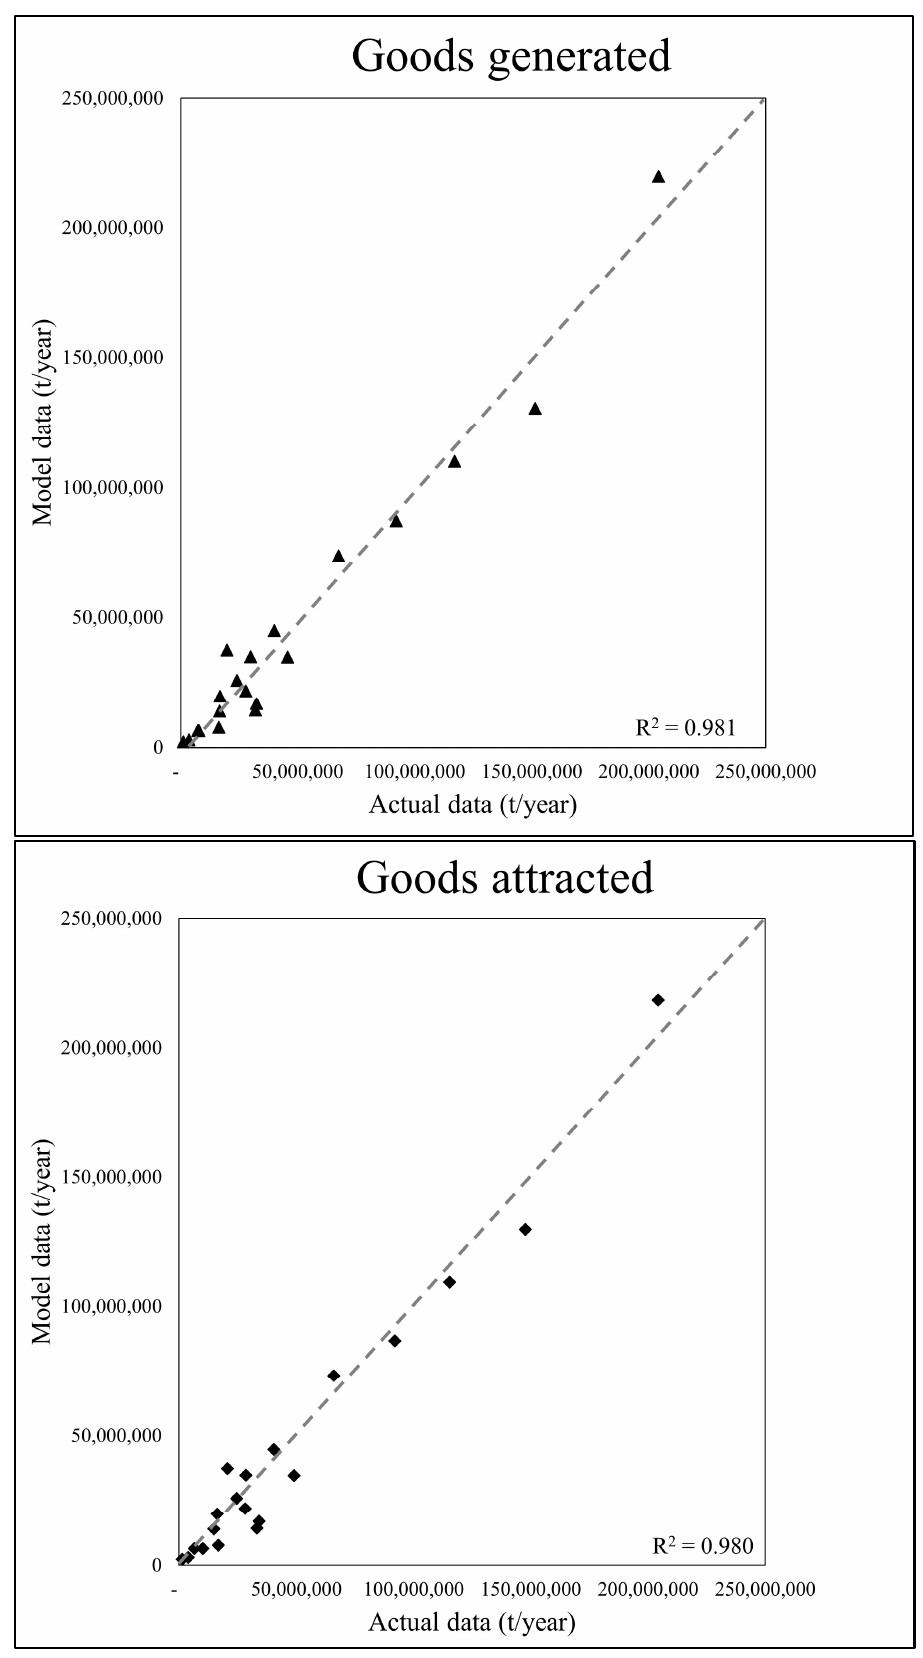
Figure 5. Comparison between model data and actual data.